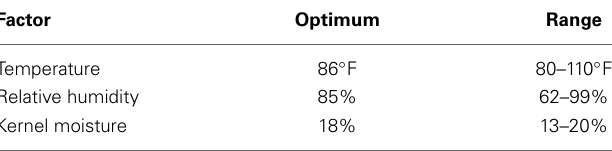
Table 1 | Conditions favoring Aspergillu s flavus development.